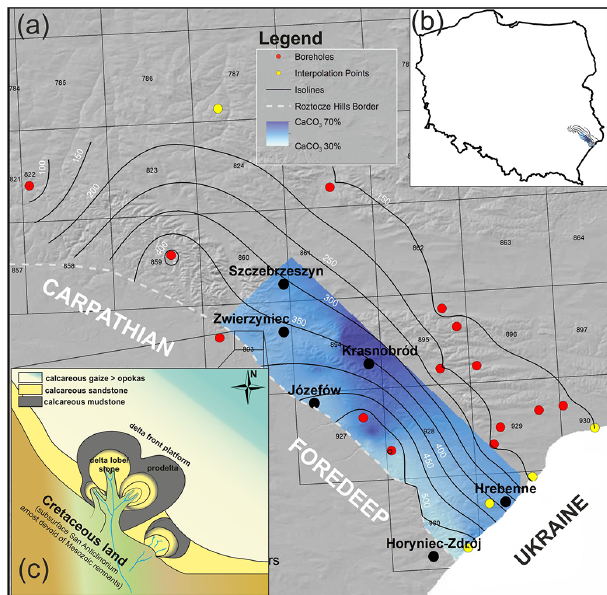
Figure 11. (a) CaCO 3 distribution pattern (blue area, compare Fig. 7) against the isolines of Campanian deposit thickness. Red dots: boreholes (compare Fig. 8); yellow dots: interpolation points; (b) general map of Poland with study area; (c) subaerial view of the Szozdy deltaic environment in relation to the distribution pattern of selected facies bordering the deltaic environment – not to scale. Squares with numbers represent the associated geological map sheets (https://geologia.pgi.gov.pl/, last access: 3 January